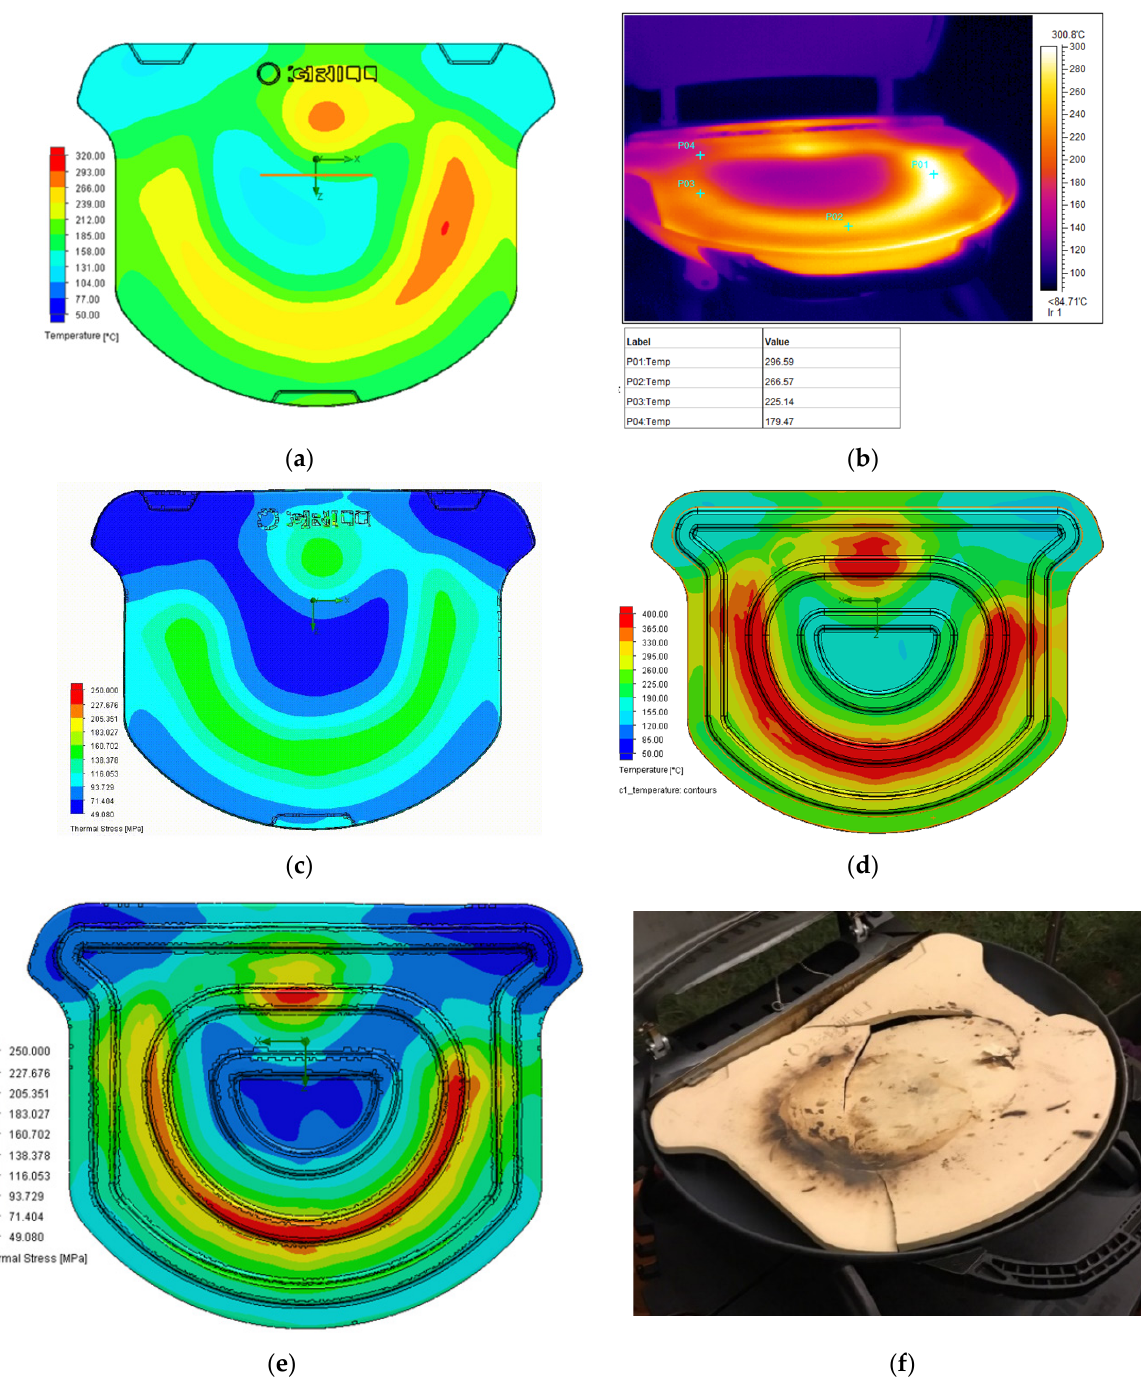
Figure 7. Original stone grill plate. ( a ) Temperature distribution on the surface. ( b ) Thermal image showing the temperature distribution on the surface. Thermal stress distributions on the ( c ) top and ( d ) bottom surfaces of the plate. ( e ) Thermal stress distribution at the bottom of the plate. ( f ) Observed cracking